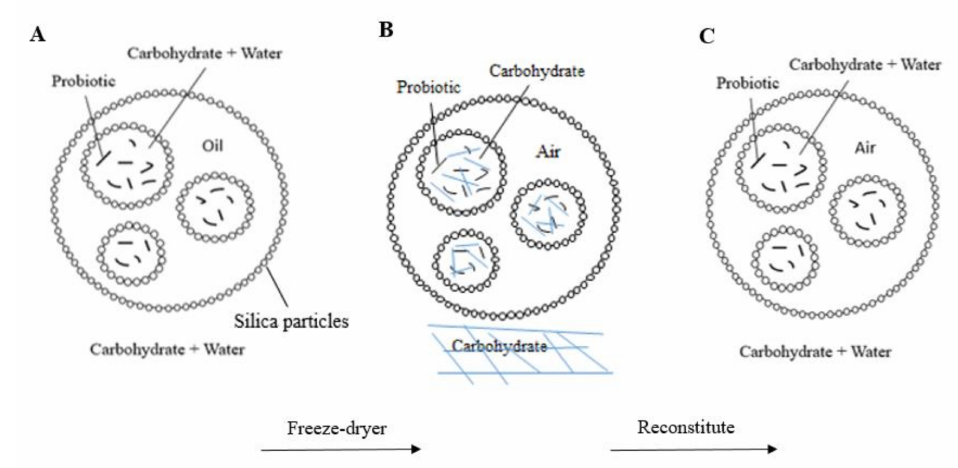
Figure 1. Schematic representation of the structure and stepwise production of antibubble-encapsulated bacteria. ( A ): an oil droplet containing emulsified water droplets containing bacteria, as produced by two consecutive emulsification steps. This water-in-oil-in-water (W / O / W) emulsion is stabilized